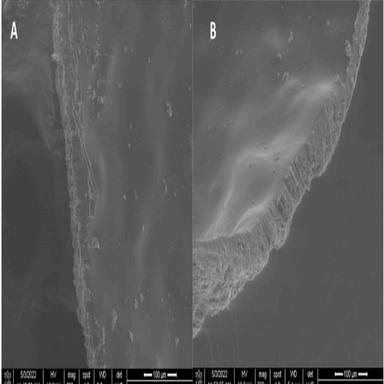
FE-SEM images of Ch/TiO2–C,N membranes(A) Top view, (B) Membrane thickness.